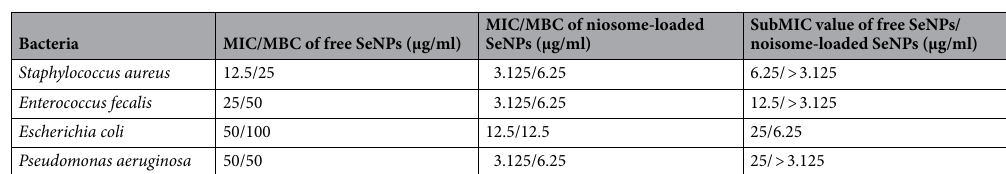
Table 5. Antibacterial activity of free SeNPs and niosome loaded SeNPs against selected pathogenic bacteria.